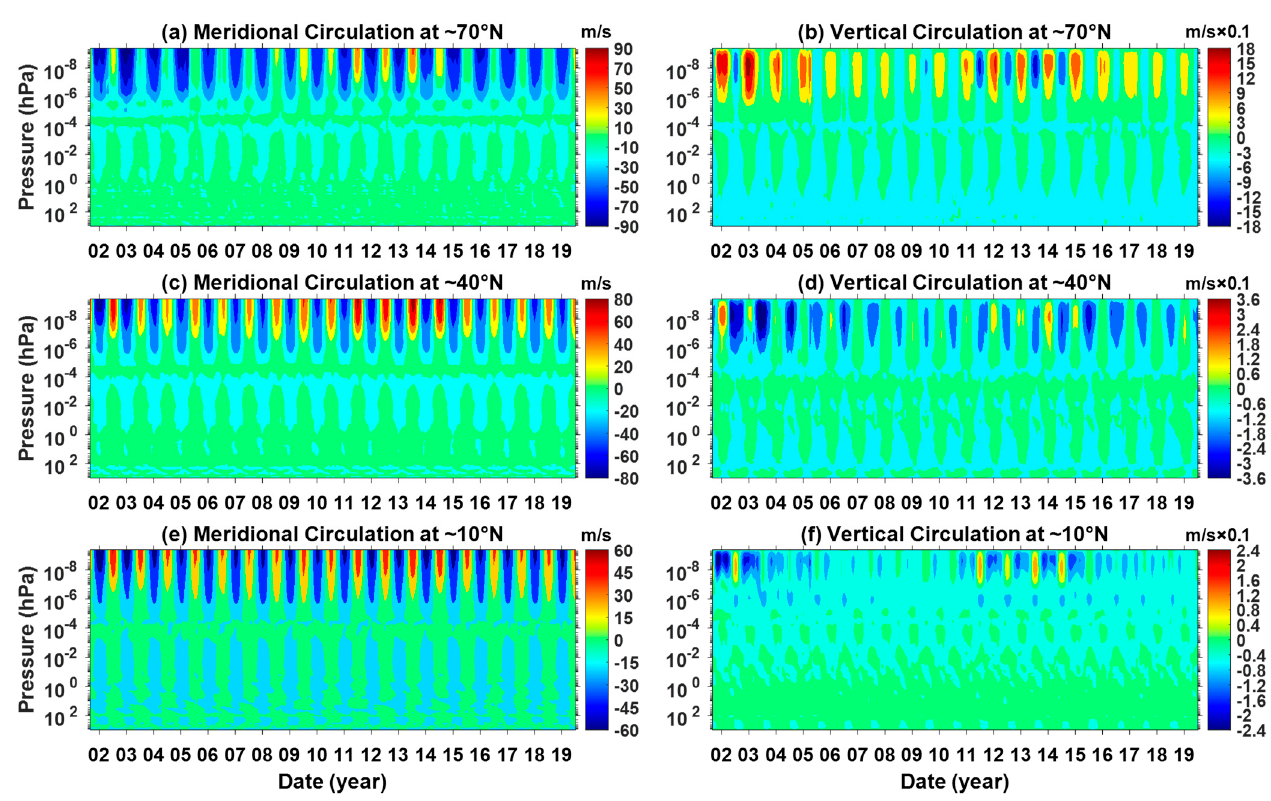
Figure 2. Temporal variations in the ( a , c , e ) meridional circulation and ( b , d , f ) vertical circulation at ( a , b ) ~70° N, ( c , d ) ~40° N, and ( e , f ) ~10° N from 2002 to 2019.